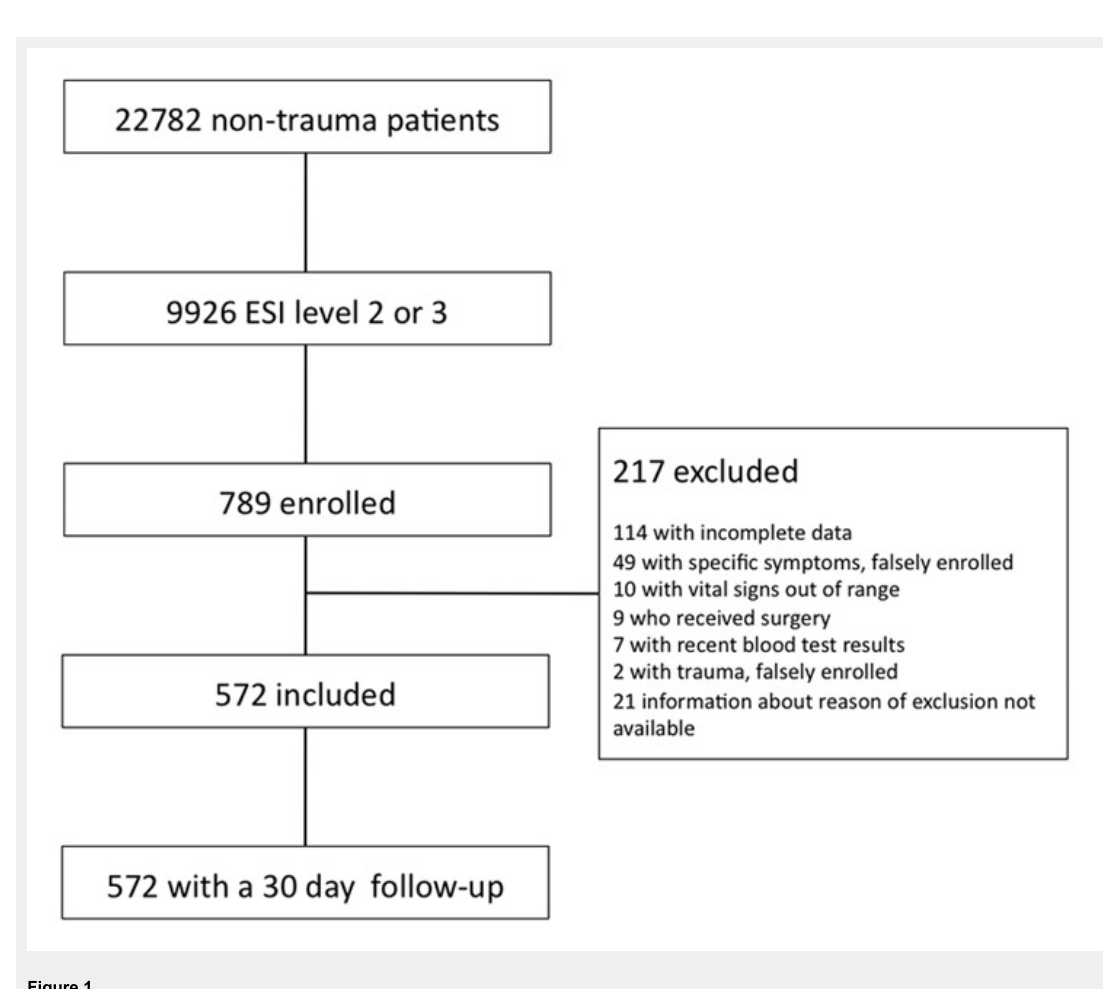
Overview of the enrolment of patients . ESI denotes emergency severity index (level 1: requires immediate life-saving intervention; level 2: high risk situation, confused, lethargic, disoriented, or severe pain/distress; level 3: two or more resources are needed; level 4: one resource is needed; level 5: no resource is